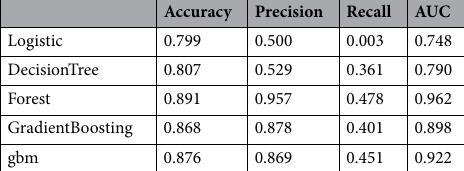
Table 2. Forecast results for training group.